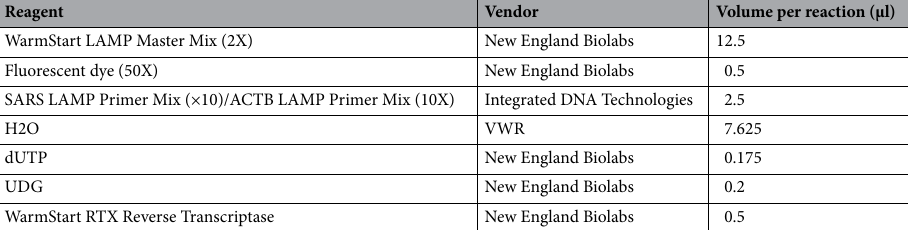
Table 3. Composition of the SARS-CoV-2 RT-LAMP reaction mix. Deoxyuridine triphosphate (dUTP) and Antarctic thermolabile Uracil DNA glycosylase (UDG) were applied to prevent cross-over contamination. Additional WarmStart reverse transcriptase was added to increase reverse transcription efficiency. During the initial method establishment, a second reactions mix was set up per sample using a LAMP primer mix targeting the human beta actin gene (ACTB) instead of SARS-CoV-2 as an external control to account for sample